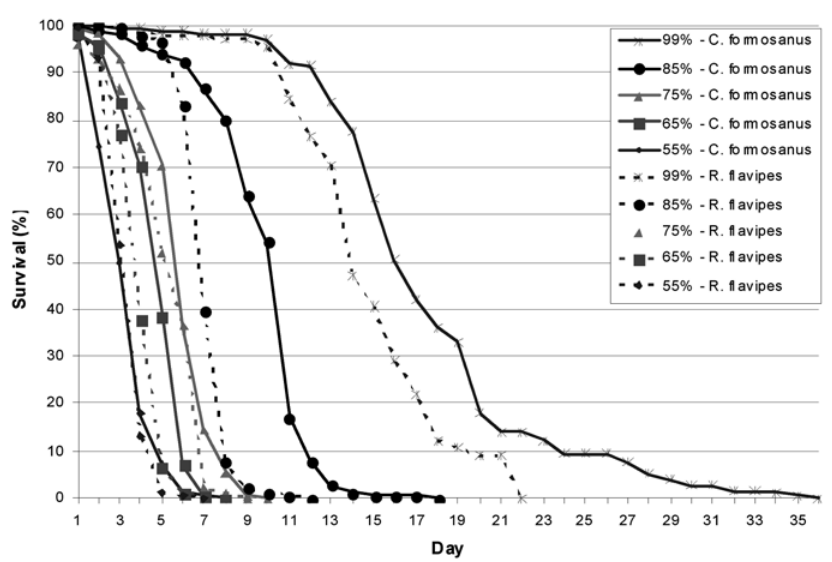
Fig. 3. Survival of small groups (18 workers + 2 soldiers) of C. formosanus and R. flavipes at 20 ° C and varying relative humidities.